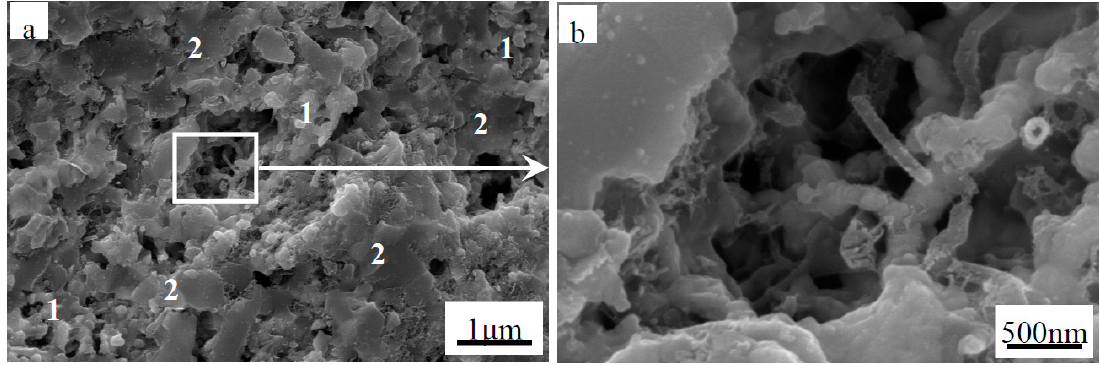
Figure 6. Secondary electron SEM images of ( a ) fracture surface of ZrB 2(micro) -5 wt % CNTs composites (“1” represents intergranular fracture, “2” represents transgranular fracture); and ( b ) magnified region.